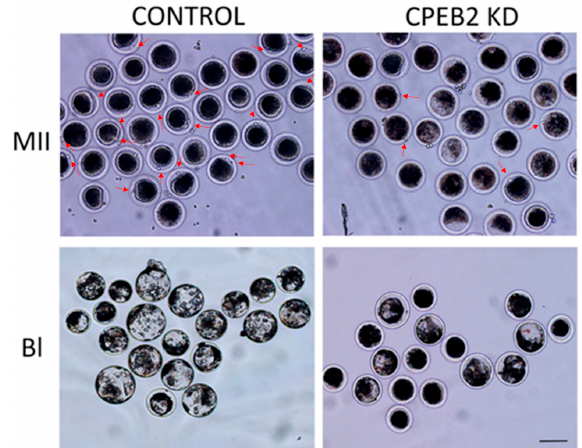
Figure 9. Morphological effect of CPEB2 KD. CPEB2 KD by dsRNA resulted in a decrease of the first polar body extrusion in MII phase porcine oocytes as well as a decrease in porcine parthenogenetic blastocyst formation and size (BL). The red arrows indicate the polar bodies. Scale bar = 200 μ m.